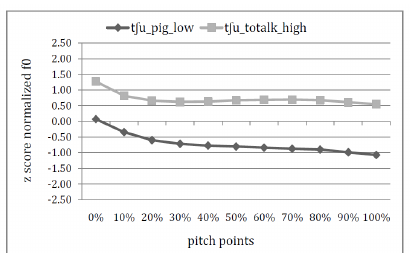
Figure 5: Normalized pitch contours for [t ʃ u], (n=20{5 speakers*4 iterations each})